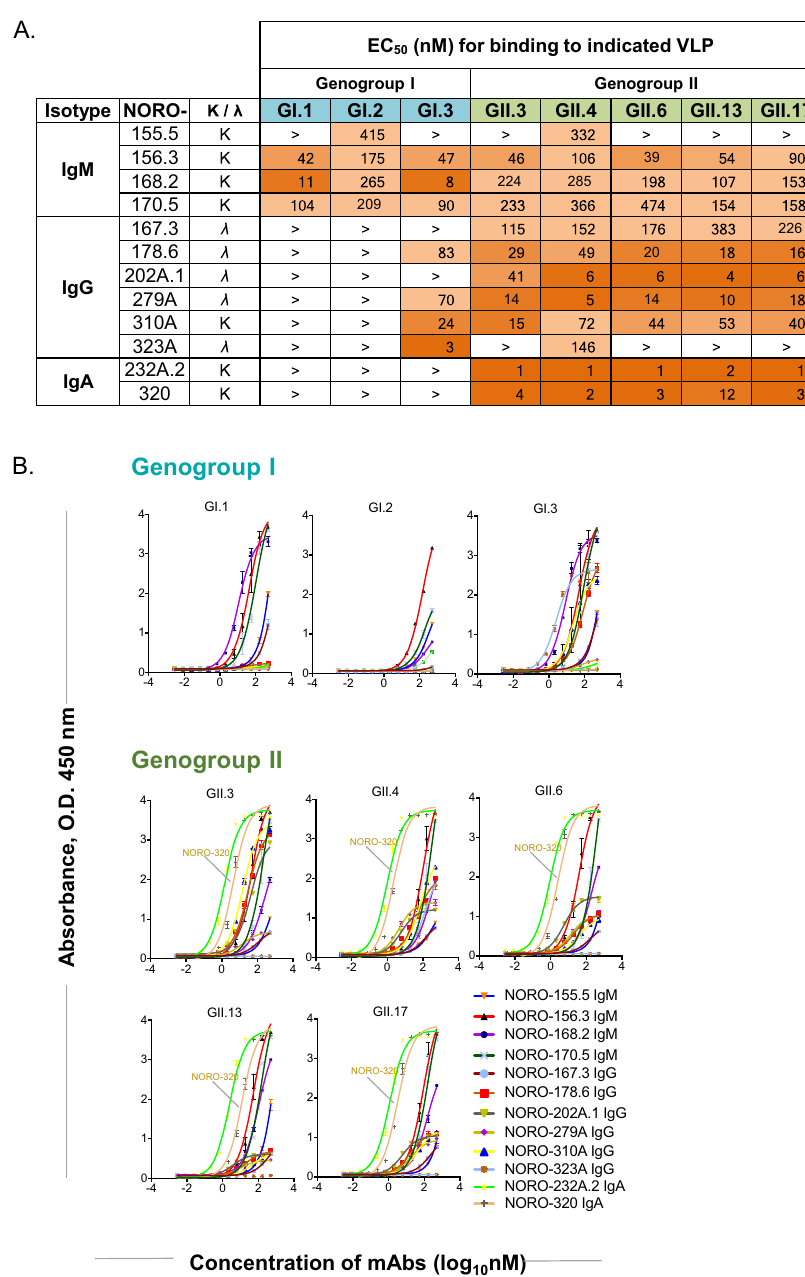
Fig. 1 Binding activity of cross-reactive human mAbs to GI and GII VLPs. An indirect ELISA was used to assess the binding activity of 12 human mAbs to GI.1, GI.2, GI.3, GII.3, GII.4, GII.6, GII.13 or GII.17 VLPs. A Half-maximal effective concentration (EC 50 ) for binding to VLPs of the indicated genotype. Listed are the isotype, light chain, and EC 50 value to GI.1, GI.2, GI.3, GII.3, GII.4, GII.6, GII.13, or GII.17 VLPs. The > symbol indicates binding was not detected at the highest concentration tested, 500 nM. Greater EC 50 values are in the lightest shade of orange and lowest EC 50 values are in the darkest shade of orange. B Representative ELISA binding curves are shown for indicated genotype. The binding curve for NORO-320 IgA, which is studied in detail here, is highlighted. Data presented are means ± SE, n = 2 independent study replicates and from one of two independent experiments with similar results. Source Data are